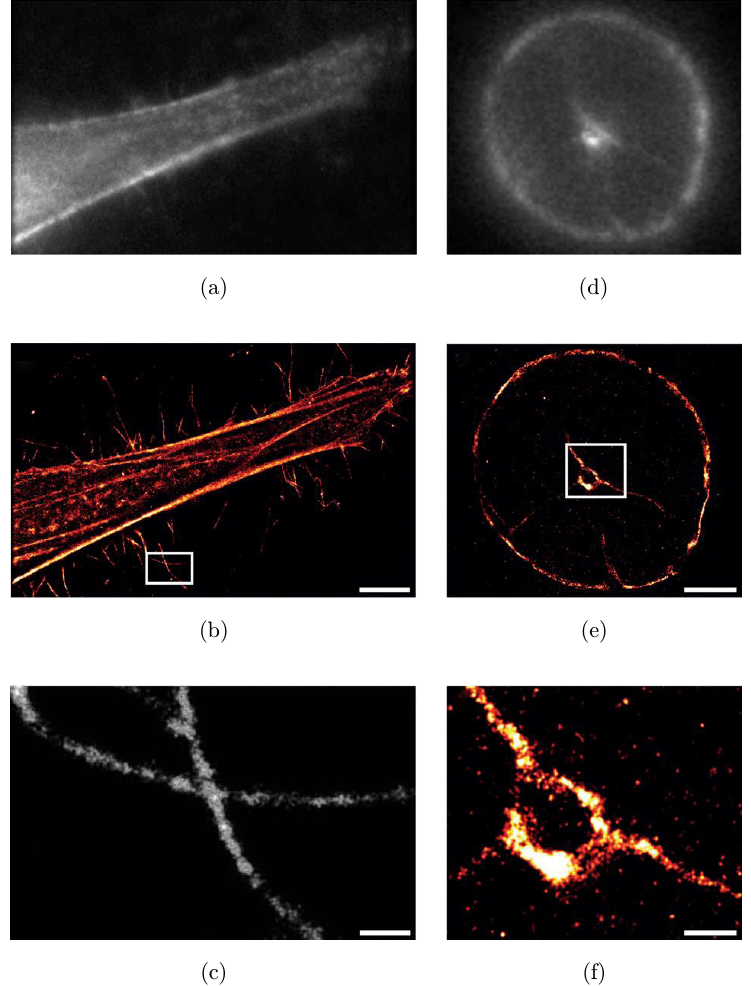
Fig. 2. Single-molecule super-resolution imaging of His 10 -tagged proteins labeled with Ni-tris-NTA AlexaFluor647 . Compared with conventional °uorescence images (a) and (d), reconstructed dSTORM images of actin (c) and laminA (d) exhibit higher optical resolution. Magni¯cations of boxed areas illustrate the high-density labeling and superior resolution obtained by using SLAP. Scale bars are 5 (cid:1) m in (b), 2.5 (cid:1) m in (e), and 0.5 (cid:1) m in (c) and (f). Adapted with permission from Ref.